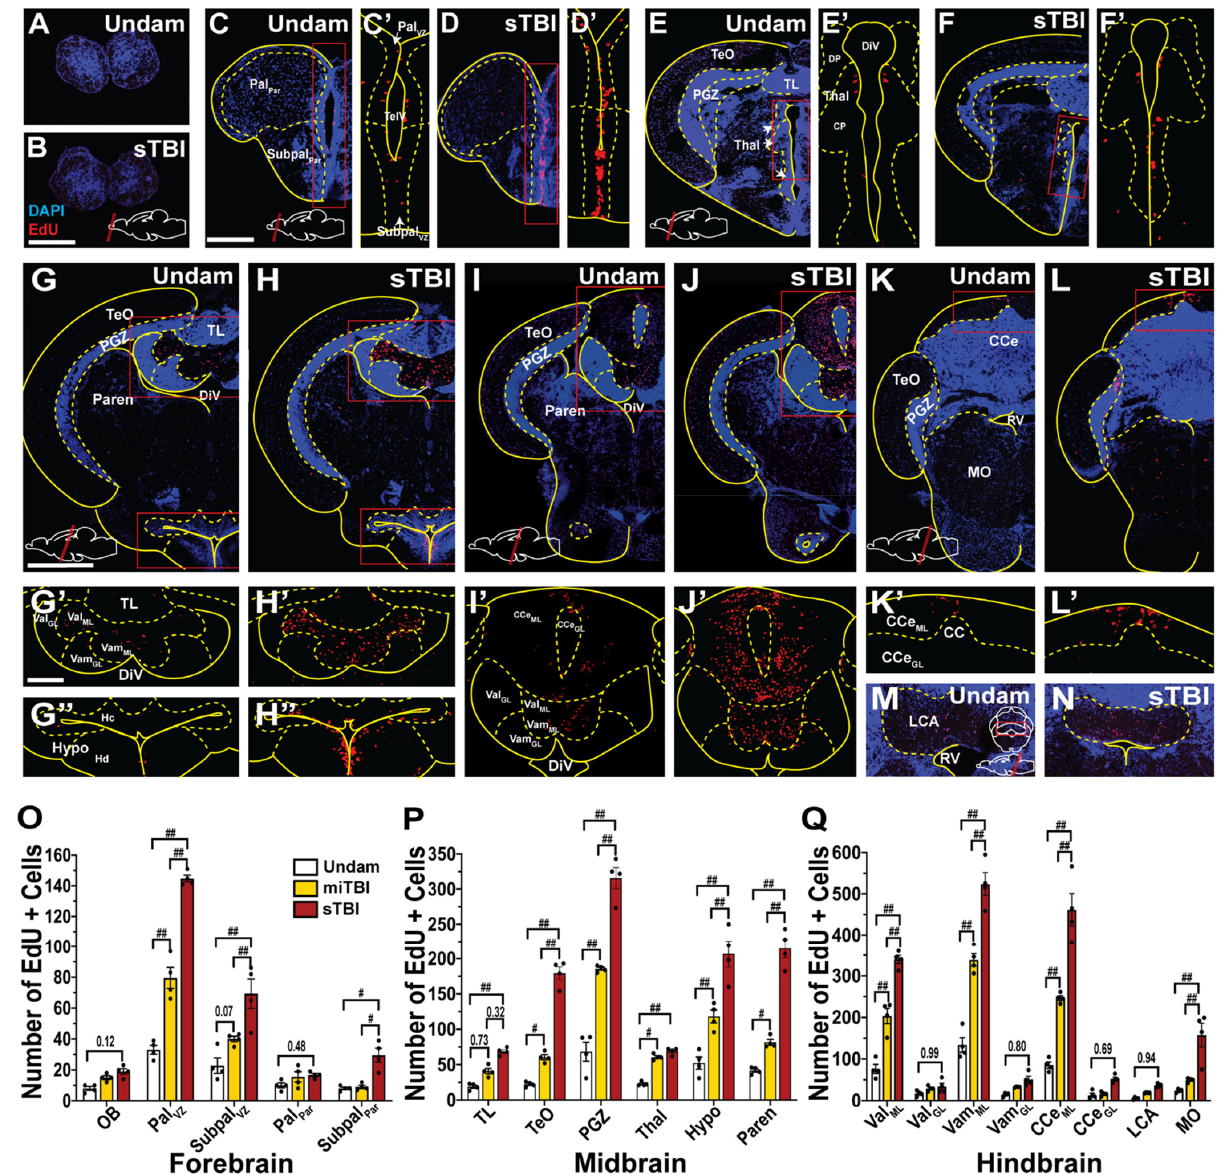
Figure 9. Injury-induced proliferation across the neuroaxis is region-specific and severity-dependent. ( A – N ) Coronal brain sections of undamaged and sTBI fish from the rostral aspect of the olfactory bulb to the caudal aspect of the lobus caudalis cerebelli. Red boxed regions in ( C – L ) are shown across the midline at a higher magnification in the corresponding prime and double prime panels. ( O – Q ) Quantification of the number of EdU-positive cells in brain subregions in undamaged, miTBI, and sTBI fish (n = 4). Solid lines in ( A – N ) denote tissue boundary, while dotted lines denote internal anatomical boundaries. Central posterior thalamic region, CP, corpus cerebelli, CCe, granule cell layer of corpus cerebelli, CCe GL , molecular layer of corpus cerebelli, CCe ML , diencephalic ventricle, DiV, dorsal posterior thalamic region, DP, lobus caudalis cerebelli, LCA, medulla oblongata, MO, olfactory bulbs, OB, parenchyma of pallium, Pal Par , ventricular/subventricular zone of pallium, Pal VZ , parenchyma of midbrain, Paren, periventricular grey zone of tectum optic, PGZ, rhombencephalic ventricle, RV, telencephalic ventricle, TeV, optic tectum, TeO, thalamus, Thal, torus longitudinalis, TL, parenchyma of subpallium, Subpal Par , ventricular/subventricular zone of subpallium, Subpal VZ , granule cell layer of lateral valvula cerebelli, Val GL , molecular layer of lateral valvula cerebelli, Val ML , granule cell layer of medial valvula cerebelli, Vam GL , molecular layer of medial valvula cerebelli, Vam ML . Scale bars: B = 100 µm, for panels A – C = 200 µm, for panels C – F ’, G = 500 µm, for panels G – L , G’ = 200 µm, for panels G’ – L’ , M , N . Mean ± SEM is depicted in O – Q . Statistical analyses were performed with a Two-way ANOVA followed by a Sidik’s multiple comparison test. # p < 0.05, ## p < 0.01.